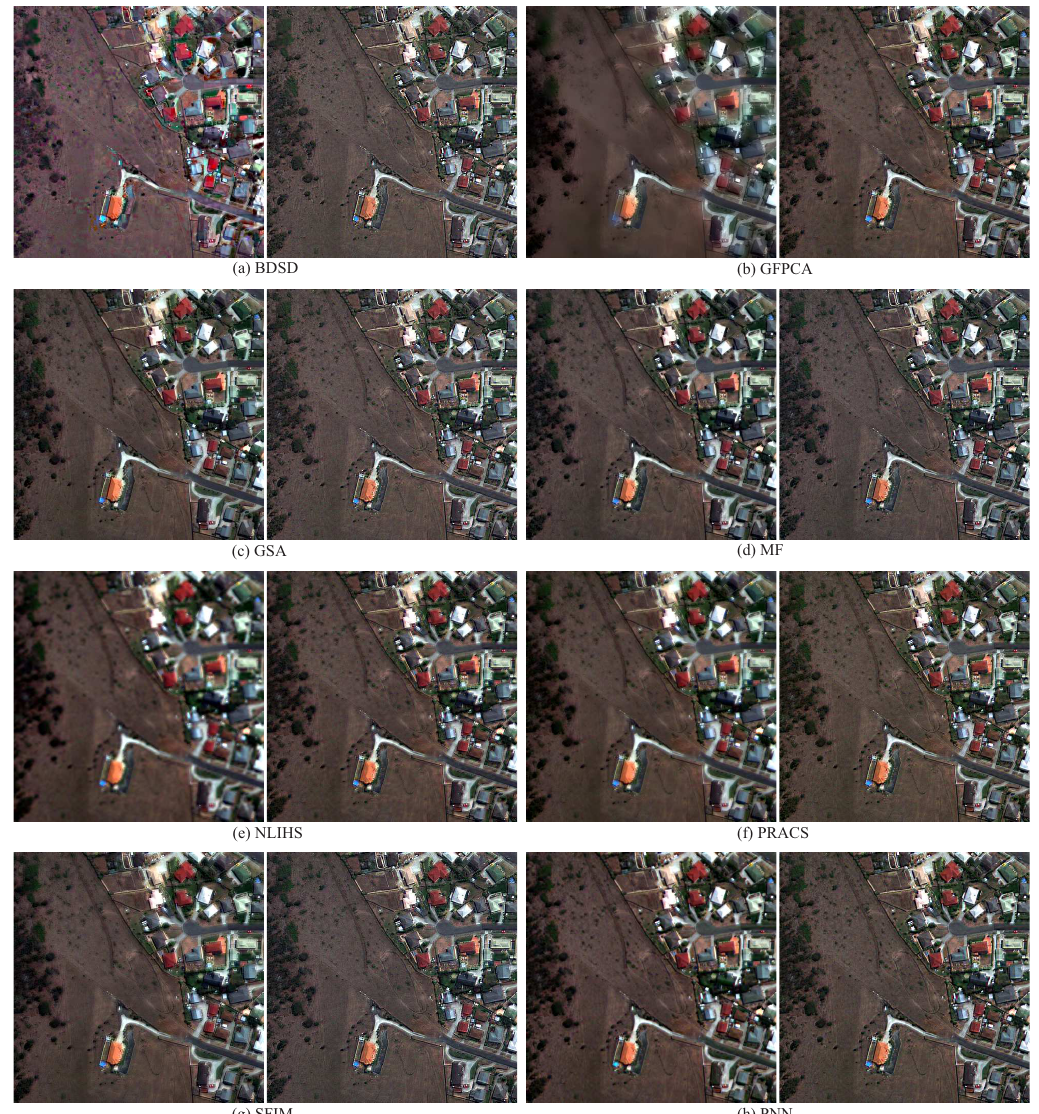
Figure 4. Visual comparison of the fused images obtained by eight methods with and without the proposed EBP as postprocessing on the GeoEye-1 dataset, ( a ) BDSD; ( b ) GFPCA; ( c ) GSA; ( d ) MF; ( e ) NLIHS; ( f ) PRACS; ( g ) SFIM; ( h ) PNN. In contrast, the results with EBP postprocessing (on the right side of each subfigure) have more spatial details and more pleasant colors than those of without EBP (on the left side of each subfigure). Best zoomed in on screen for visual comparison